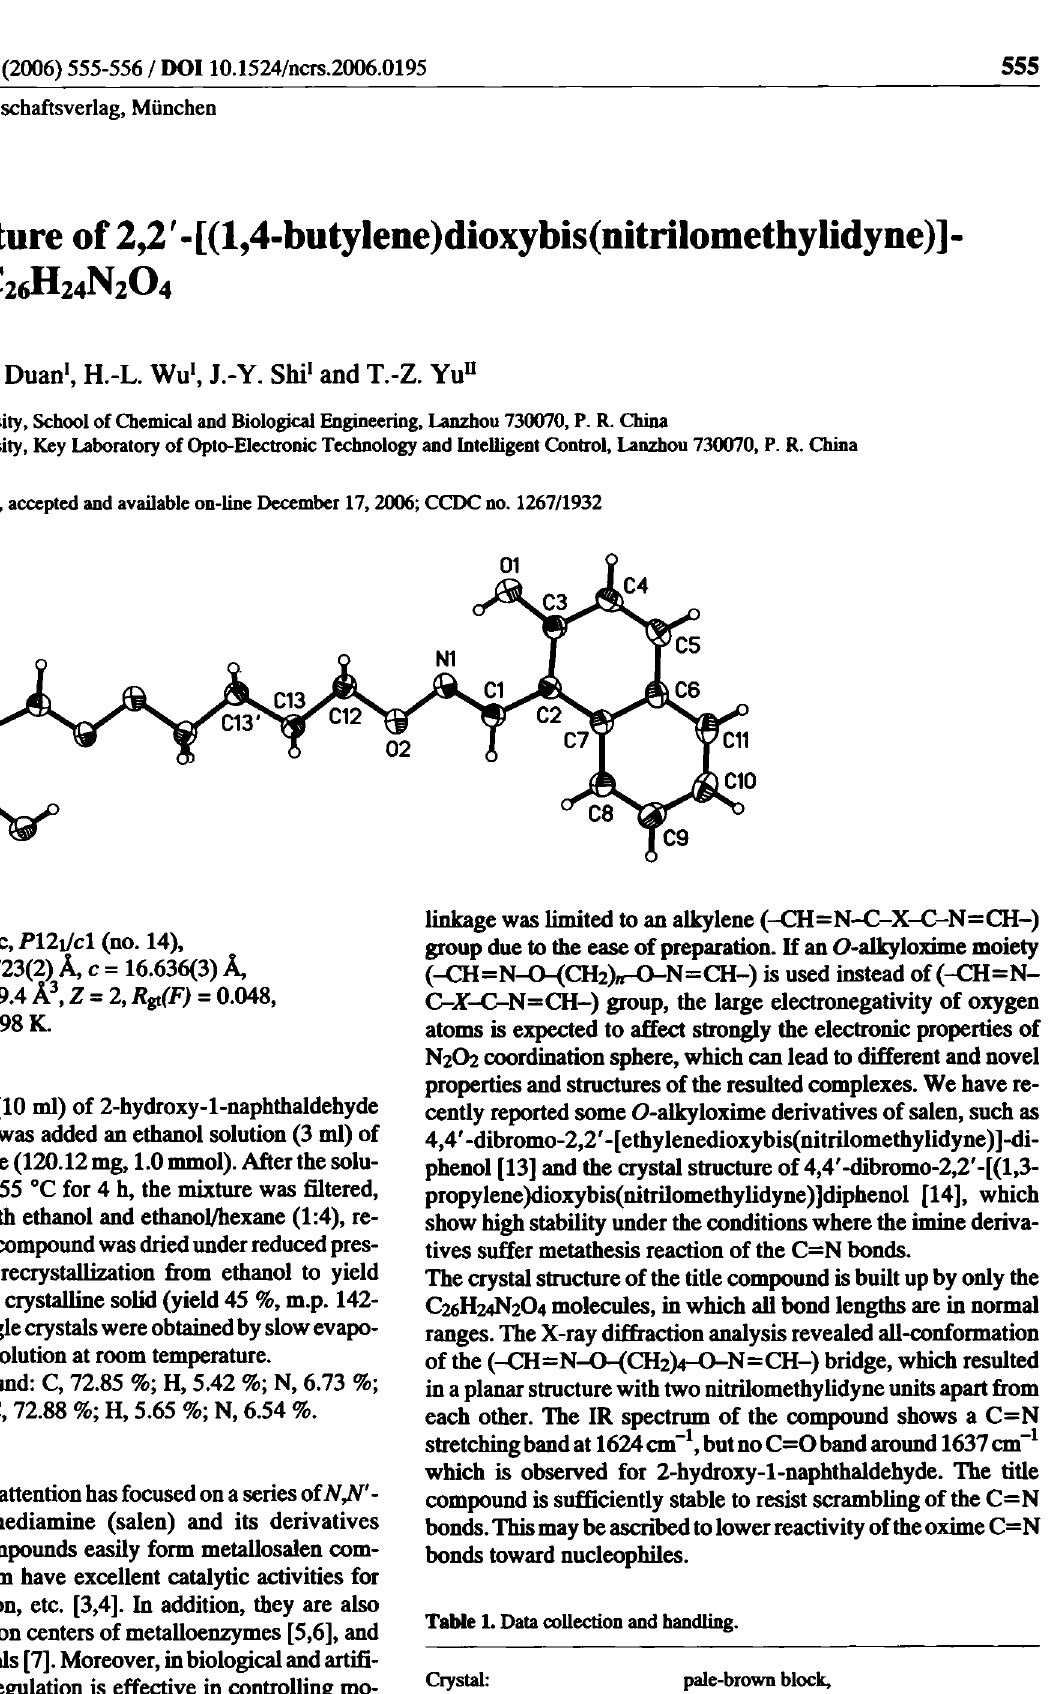
Table 1. Data collection and